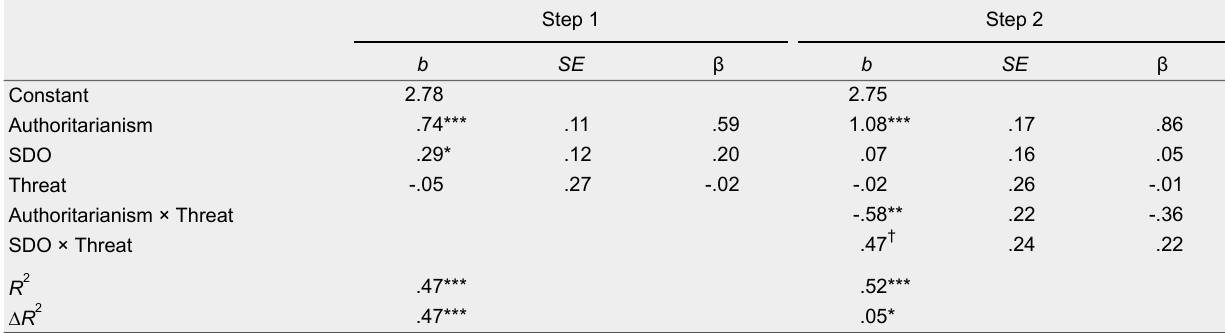
Study 2: Moderated multiple regression analysis for the Authoritarianism dimension (N =